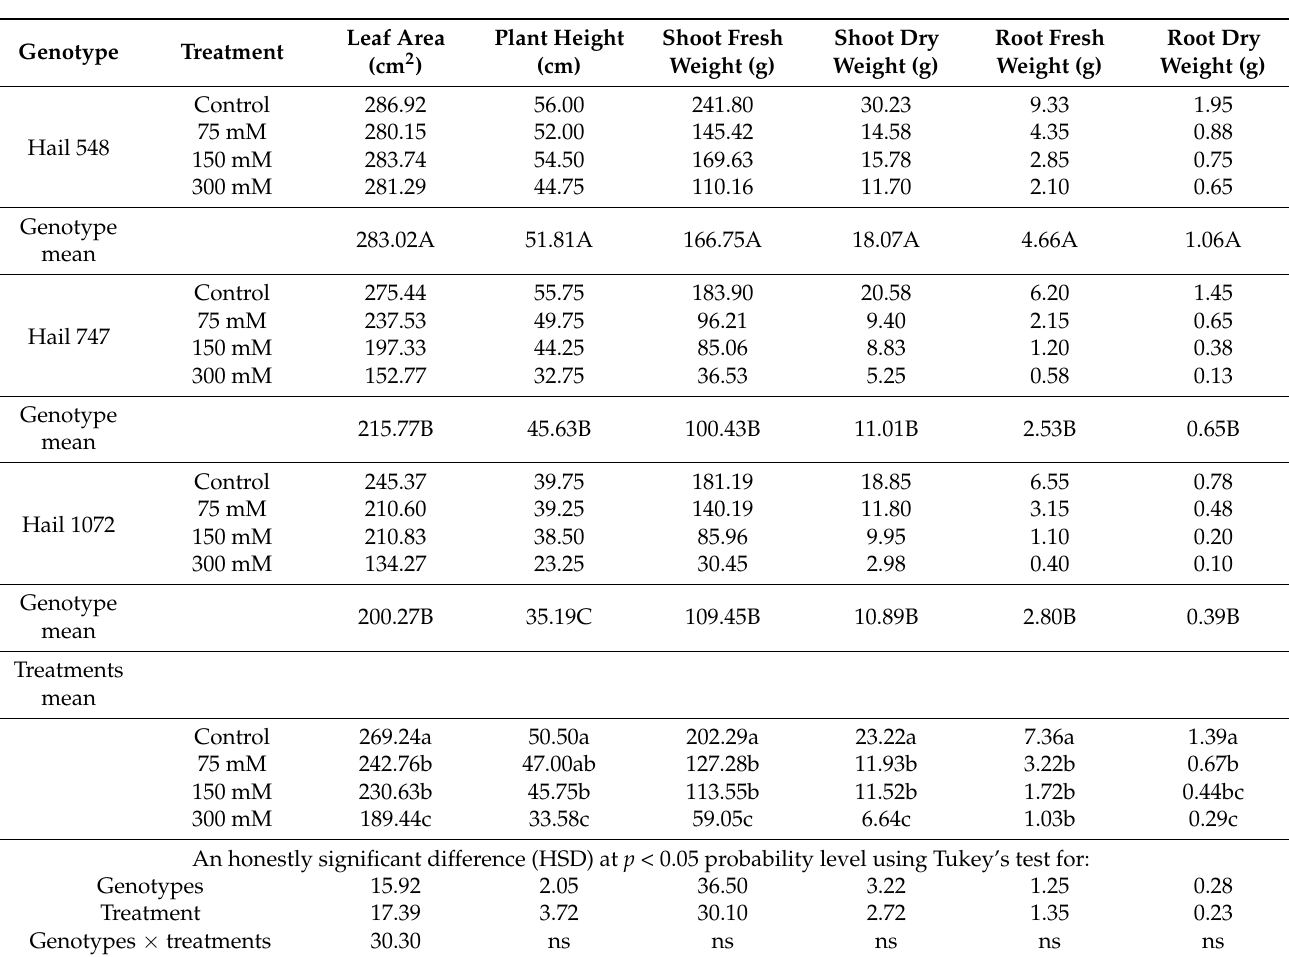
treatment. Table 1. Mean values of growth-related traits for three Hail landraces under four NaCl stress treatments. Values are the mean of four replications. According to Tukey’s test, different letters within the same columns show significant differences ( p < 0.05). The higher cases are the differences among genotypes, and the lower cases are the differences among treatments’ mean. ns: means not